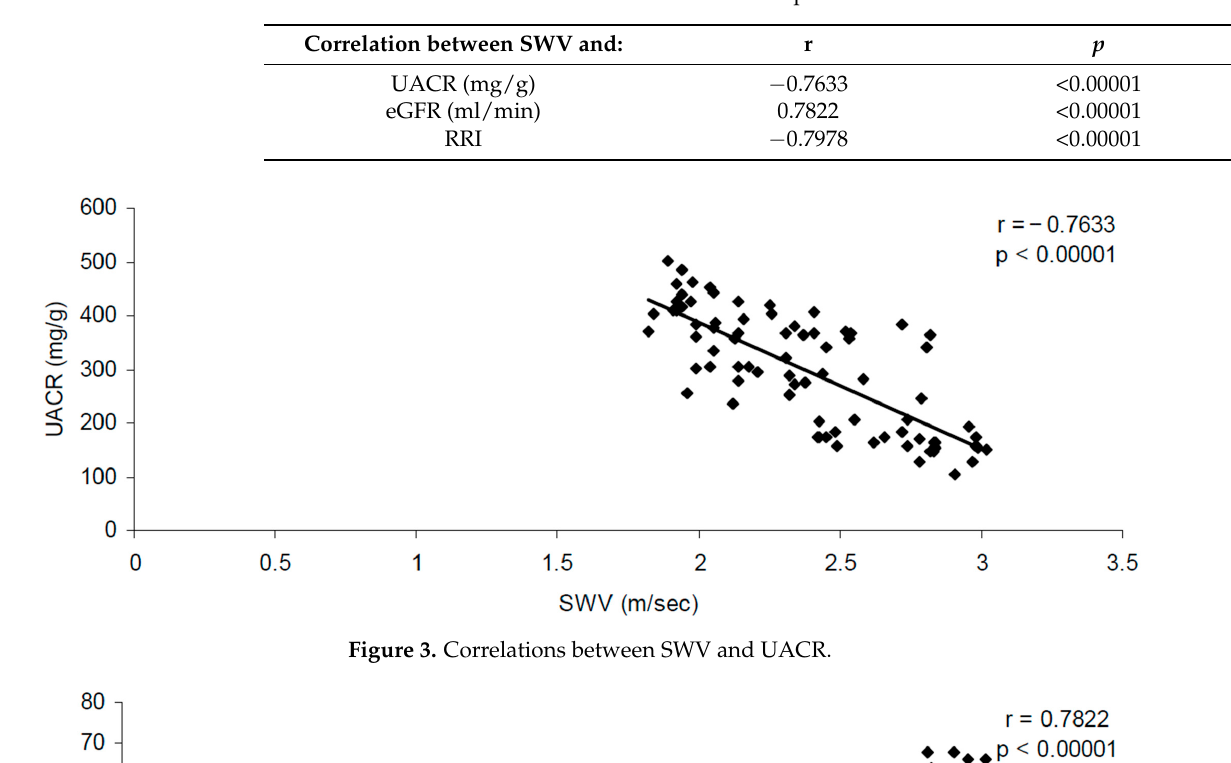
Table 4. Correlations between SWV and monitorized parameters.